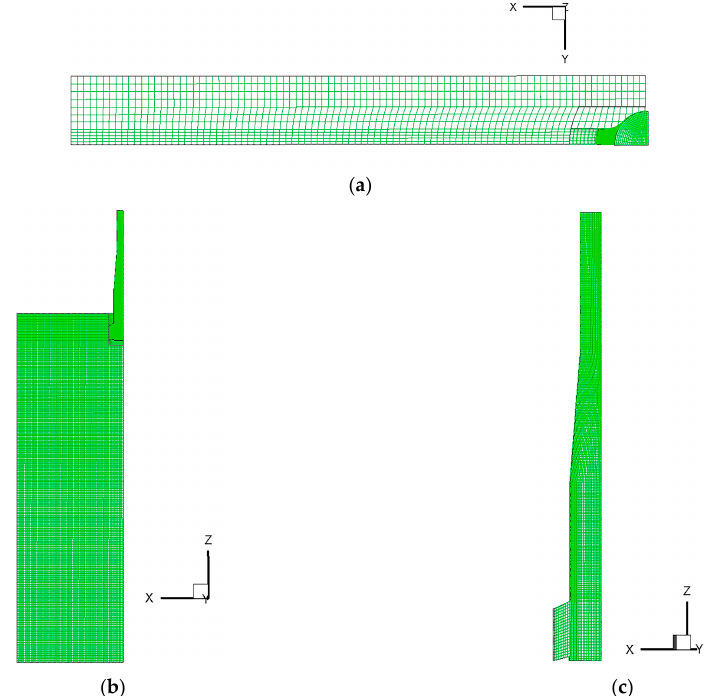
Figure 4. Schematic of meshes used for numerical simulation: ( a ) top view; ( b ) side view; ( c ) submerged entrance nozzle.